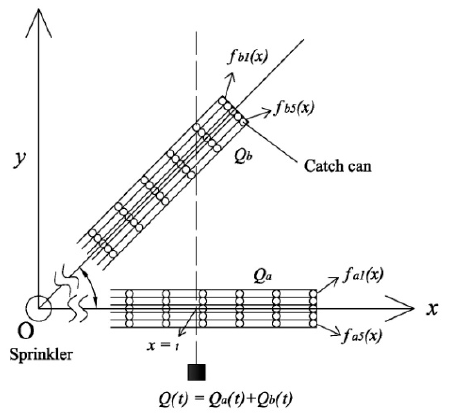
Figure 3. Coordinate system layout for determining the water distribution pattern from a sprinkler in motion.